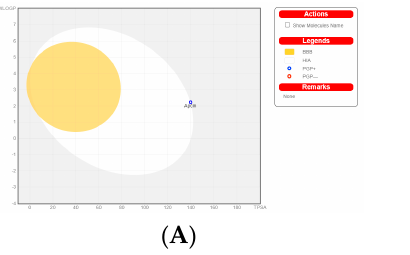
Figure 8. Bioled-egg model analysis using the SwissADME website. ( A ) Bioled-egg model analysis of Apcin; ( B ) Bioled-egg model analysis of compound 20. ( C ) Bioled-egg model analysis of compound 27. The blue dots indicate that the molecule is predicted to be a substrate for P-glycoprotein (PGP + ) and will therefore be actively pumped out of the brain or gastrointestinal lumen. If the compound is not to be a substrate of p-glycoprotein (PGP, the relevant points are shown in red. WLOGP is the method for evaluating the lipophilicity of compounds shown in the ordinate diagram, and TPSA is the polar surface-area unit A of the compound.